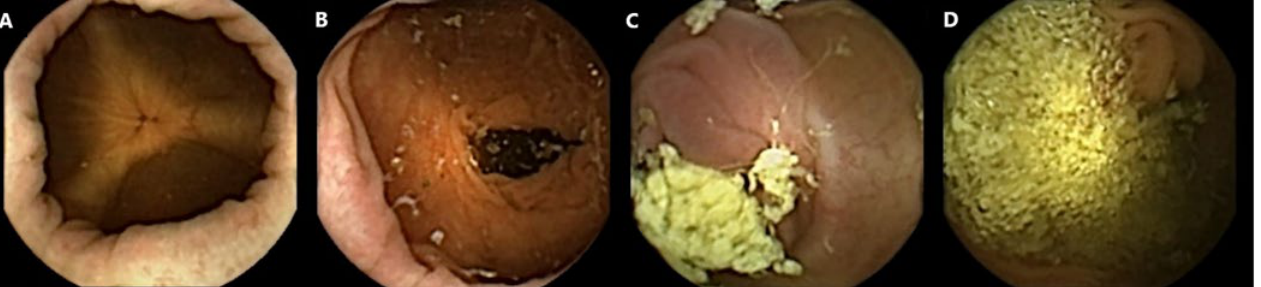
Figure 1. Examples of colon capsule video frames graded according to the Leighton–Rex scale. ( A ) Excellent. ( B ) Good. ( C ) Fair. ( D )